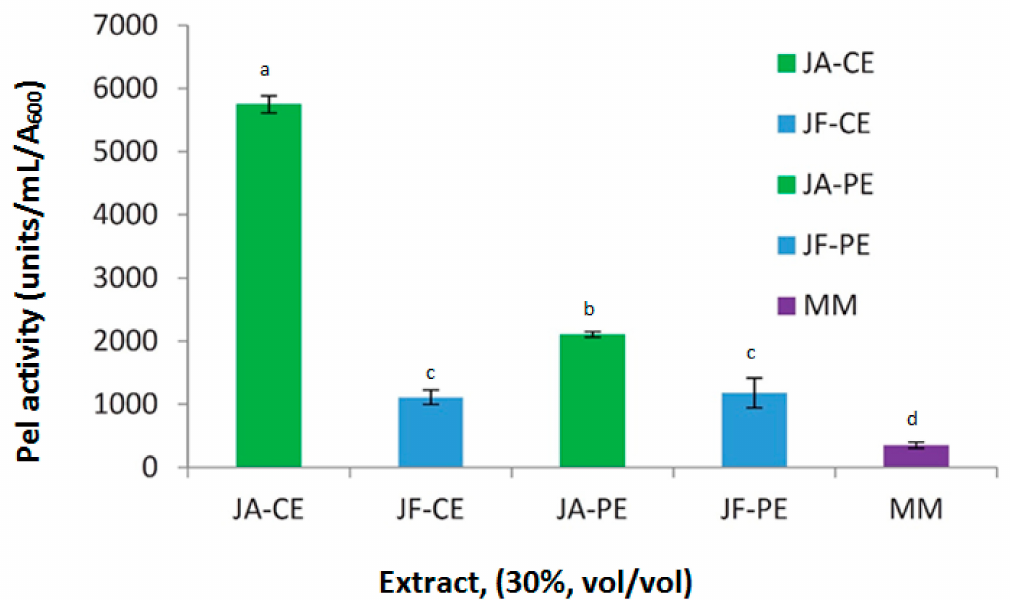
Figure 1. Levels of Pel produced by P. carotovorum strain KD100 / pAKC1031 ( pel1-lacZ ) grown in MM supplemented with filtered and autoclaved extracts of celery (CE) and potato (PE). Cultures were grown overnight, and culture supernatants were collected and assayed for Pel activity. Bacterial growth was measured with A 600. Pel activity was kinetically determined from culture supernatants at 235 nm and expressed as units / mL / A 600 . Means with di ff erent letters are significantly di ff erent by Student’s t -test at P < 0.05. Abbreviation: JA-CE, juice autoclaved CE; JF-CE, juice filtered CE; JA-PE, juice autoclaved PE; JF-PE, juice filtered